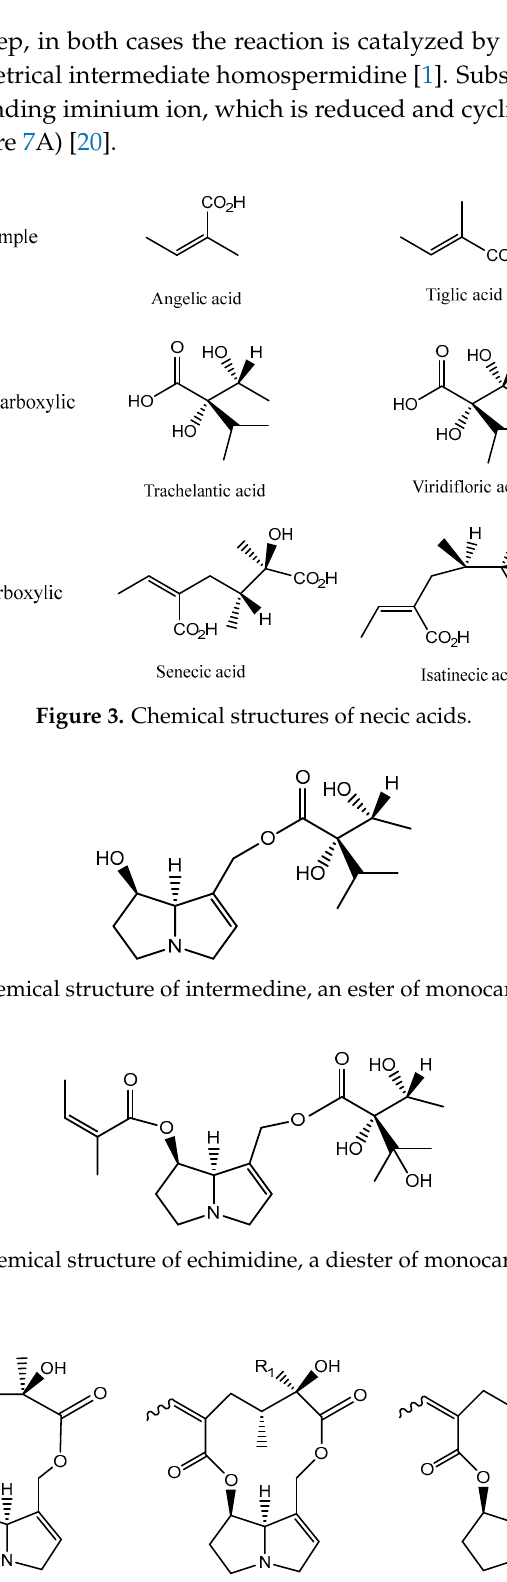
Figure 6. Chemical structure of tricodesmine, senecionine (R 1 = H)/retrorsine (R 1 = OH) and seneciphylline (R 2 = H)/riddeline (R 2 = OH), macrocylic diesters.